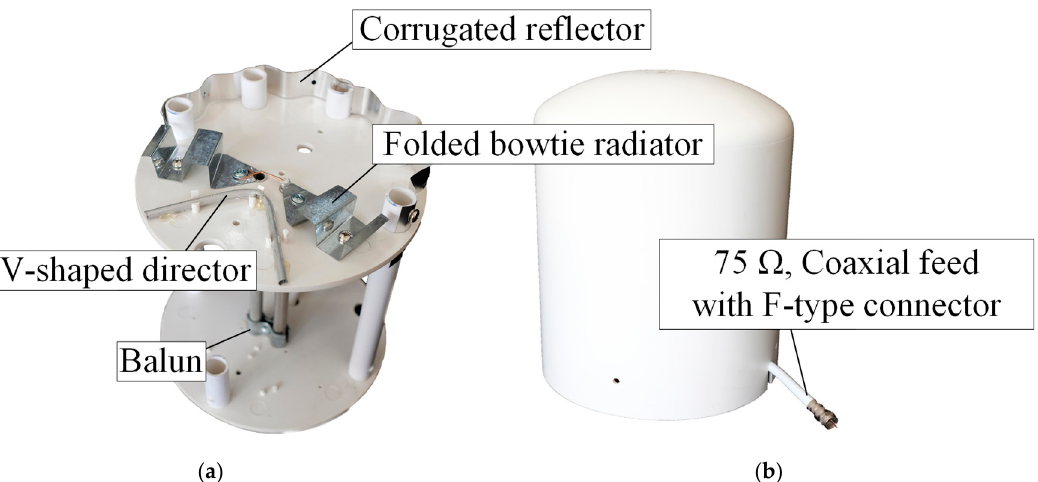
Figure 16. Prototype of the portable wideband directional antenna scheme: ( a ) without radome, ( b ) with radome.